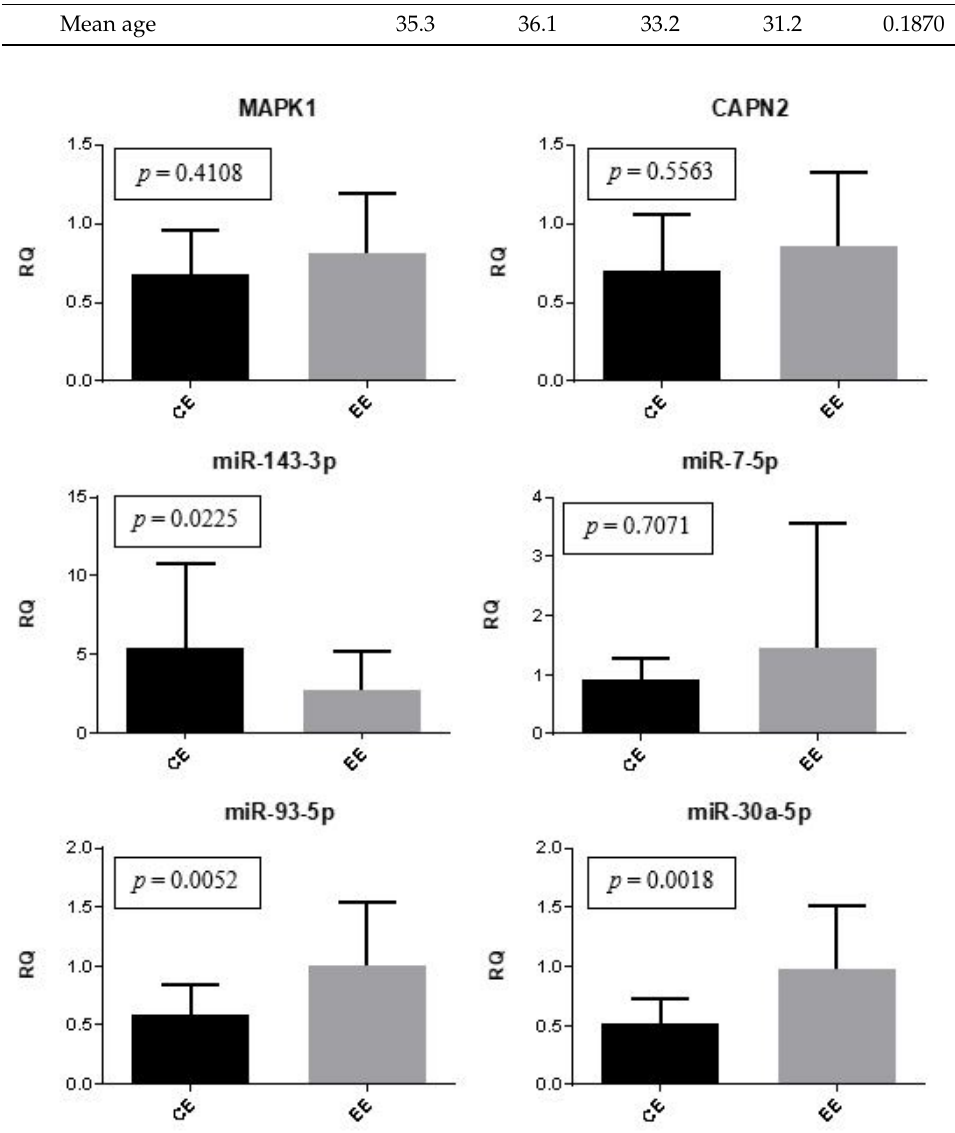
Figure 2. Eutopic endometrium (control versus women with endometriosis). Representation of the mean ( ± standard error) gene and miRNA expression in the control eutopic endometrium (CE) ( n = 10) and the eutopic endometrium of women with endometriosis (EE) ( n = 30). The Mann-Whitney test was used in this analysis.